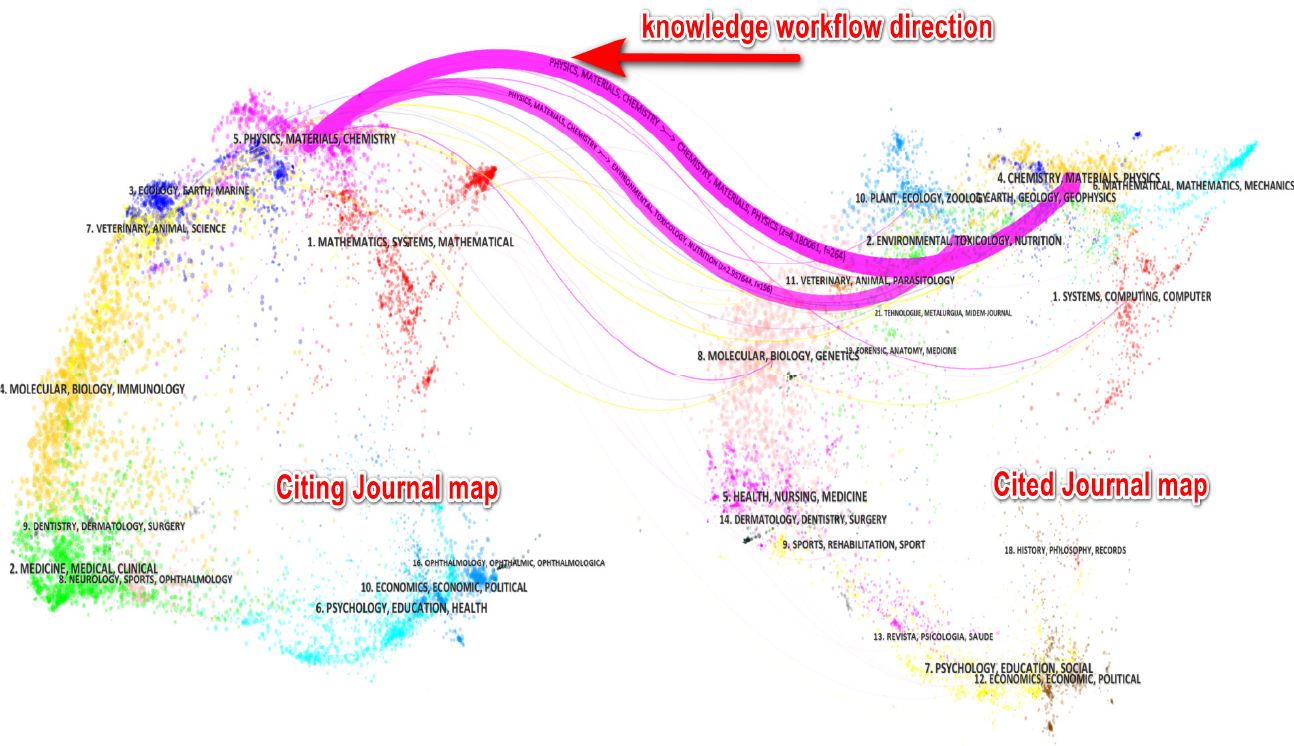
Figure 23. Overlay journals analysis of all 69 publications (generated using CiteSpace on data).